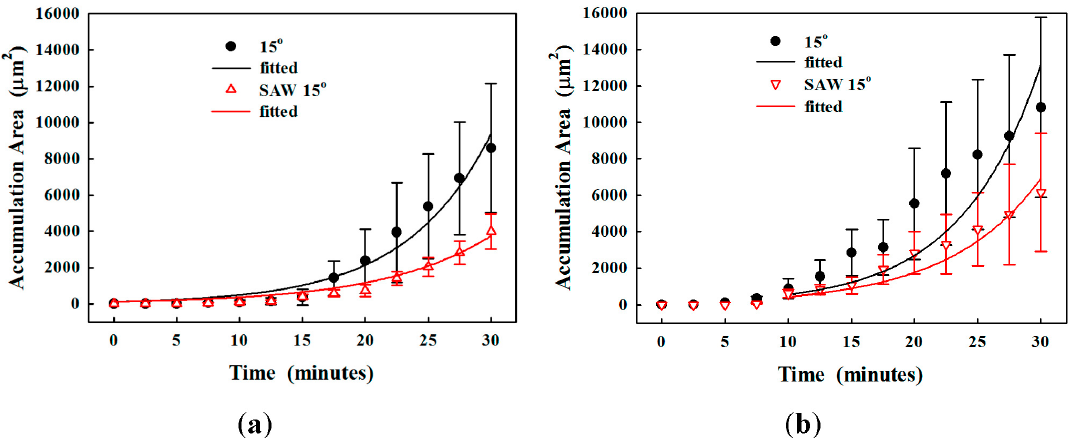
Figure 12. Progressive particle accumulation in the microchannel at the constriction angle of 15° with 1% microparticles in ( a ) 3%; and ( b ) 5% alginate solution, without and with the actuation of the standing surface acoustic wave (SSAW).